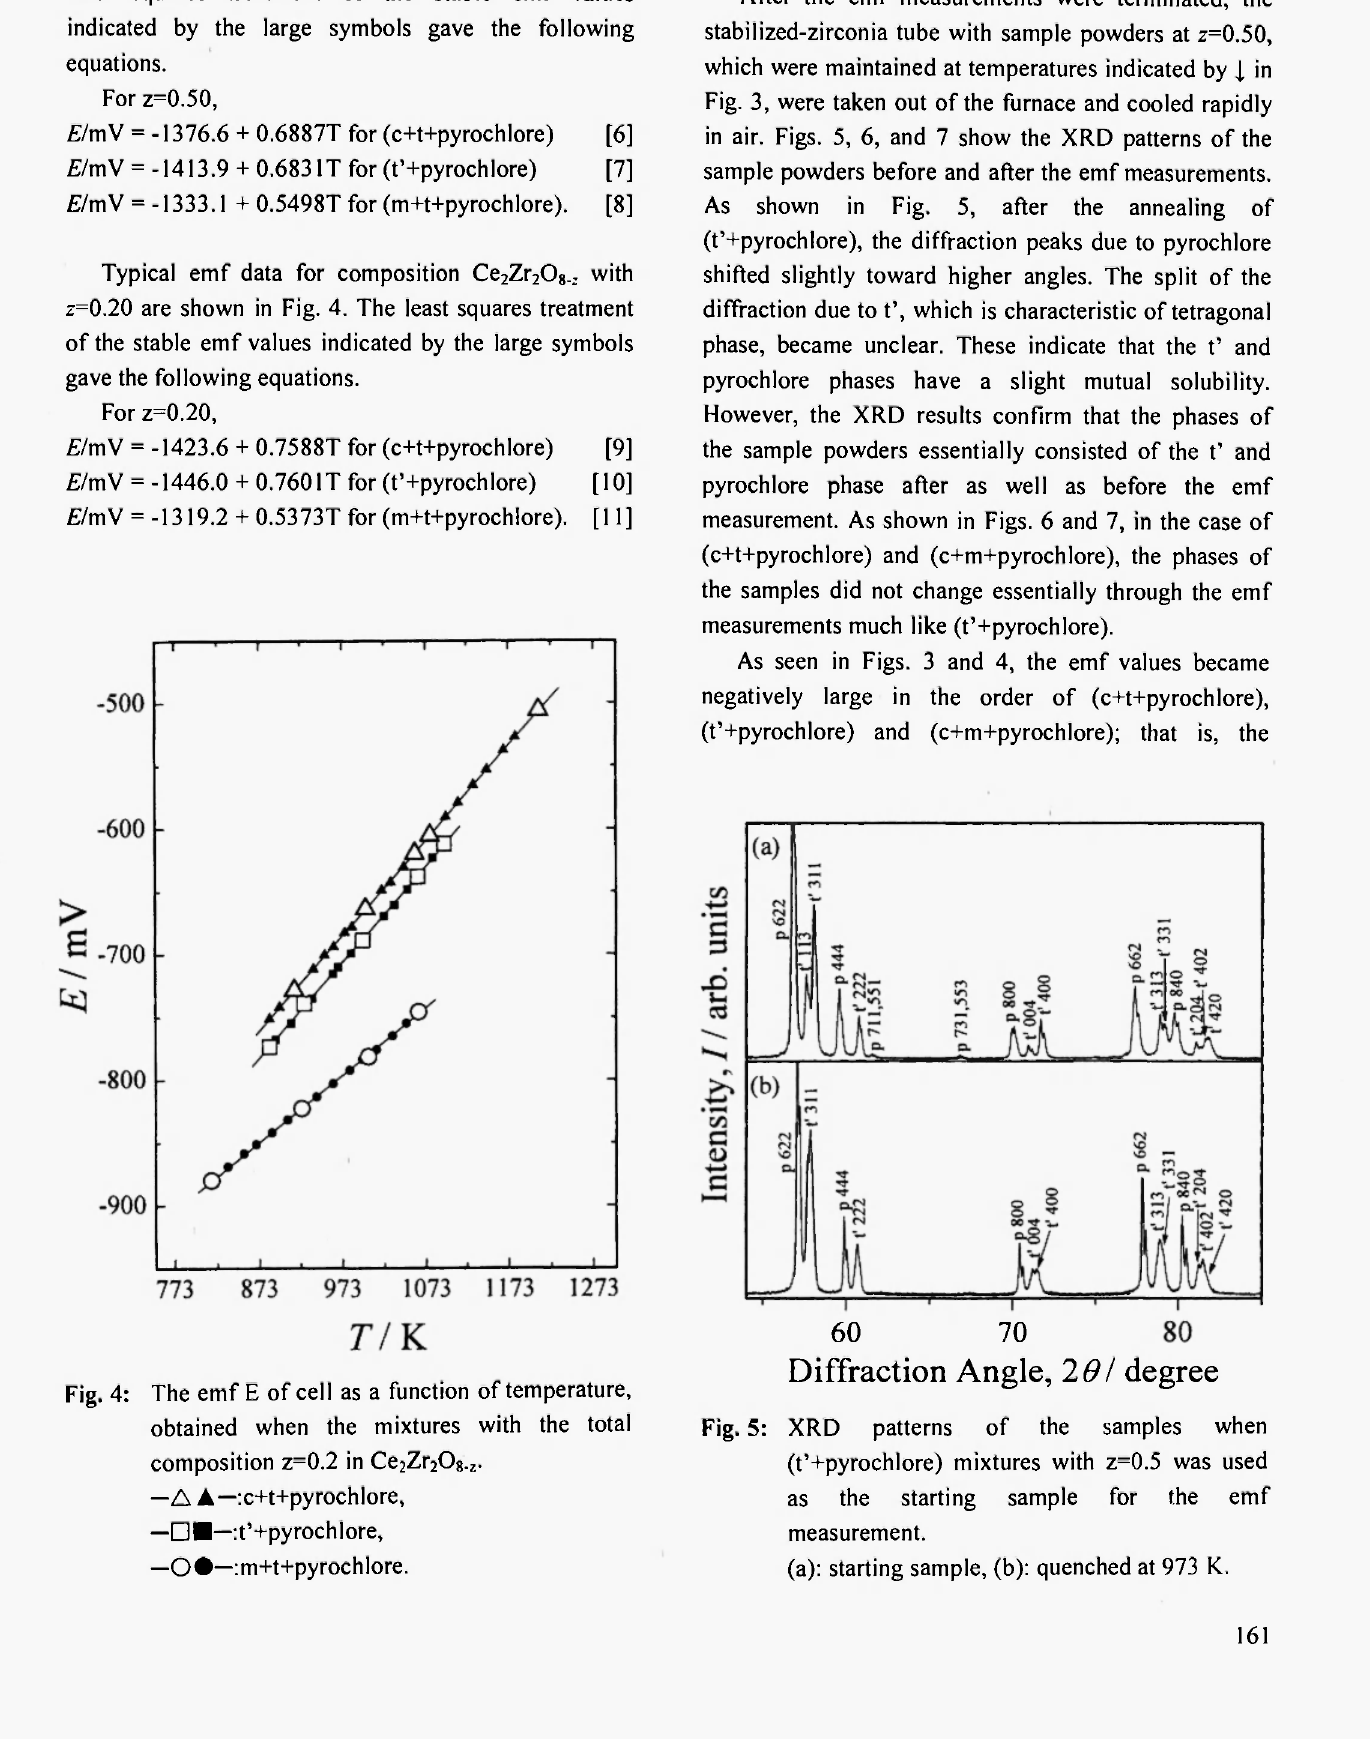
Fig. 5: XRD patterns of the samples when (t'+pyrochlore) mixtures with z=0.5 was used as the starting sample for the emf